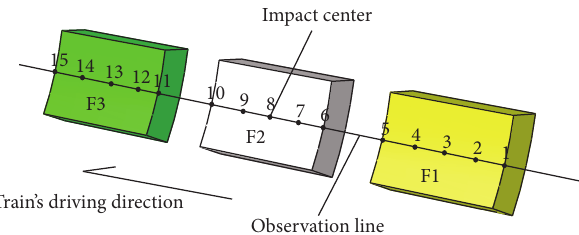
Figure 4: Arrangement of the monitoring points.